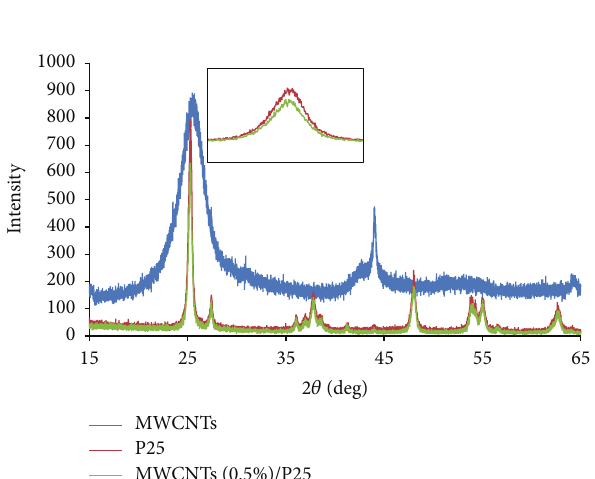
Figure 6: XRD for the MWCNTs, P25, and MWCNTs (0.5%)/P25 composites.